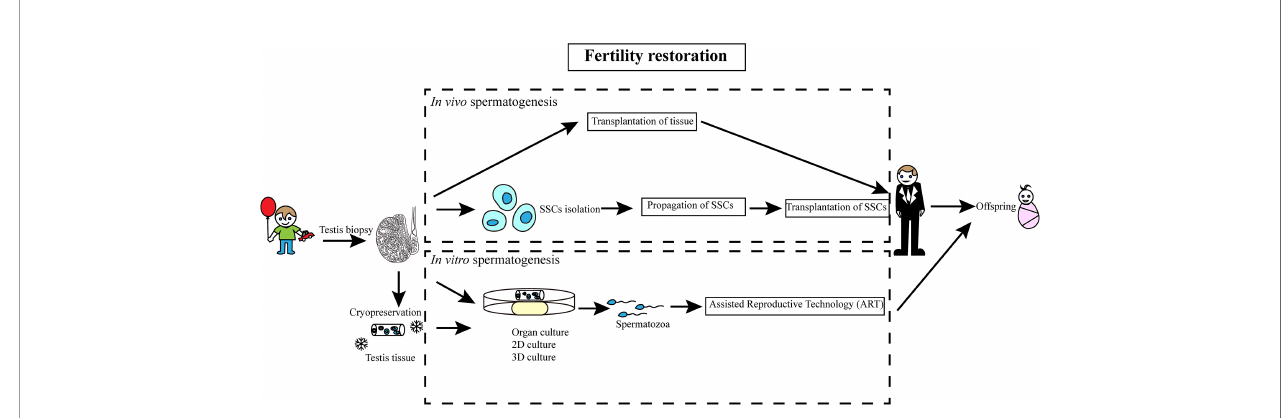
FIGURE 2 | Schematic diagram of SSC-based fertility restoration in humans. A sample of testicular tissue of prepubertal boys, who receive gonadotoxic treatment, is retrieved and cryopreserved. Spermatogenesis may be induced after treatment either in vivo or in